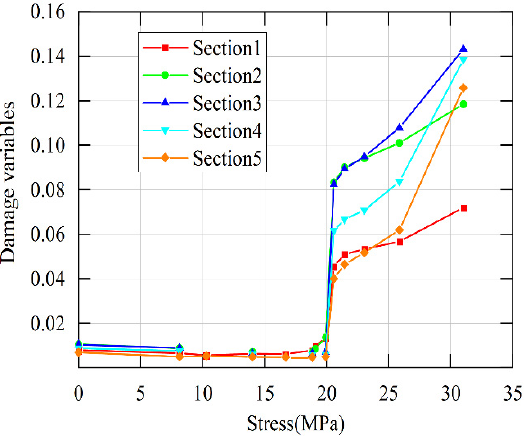
Figure 9. Relationship between damage variables and stress on each scanning section.